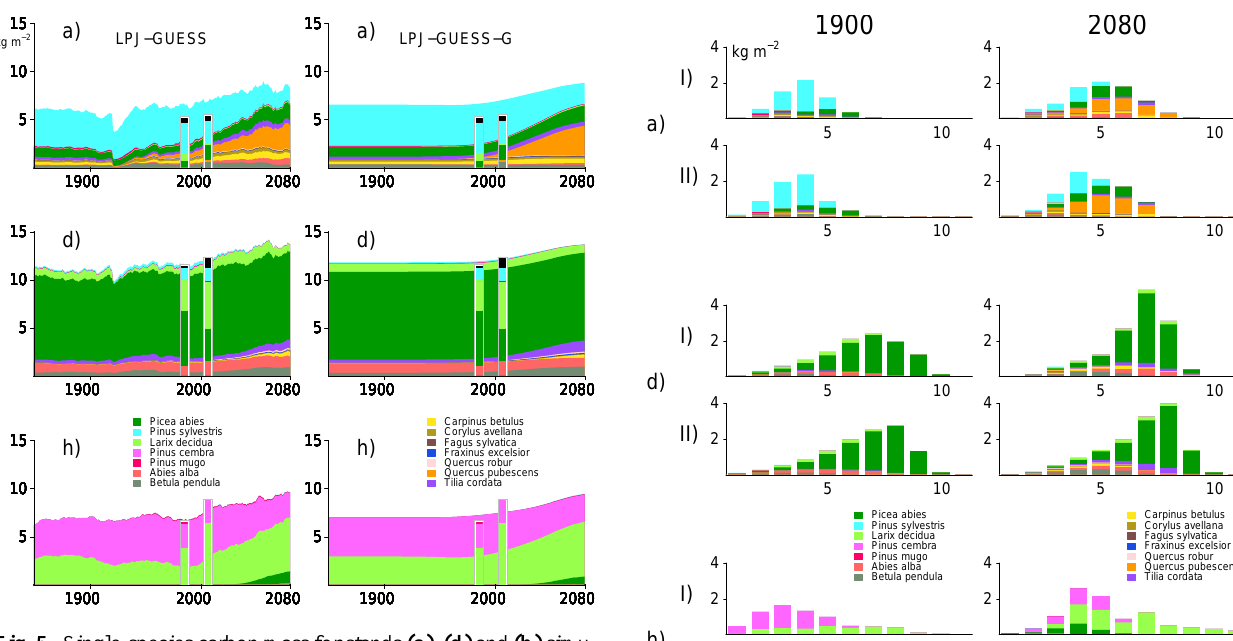
Fig. 5. Single-species carbon mass for stands (a) , (d) and (h) simu- lated with LPJ-GUESS and LPJ-GUESS-G. LPJ-GUESS: stochas- tic simulation run using 400 replicate patches, LPJ-GUESS-G: GAPPARD applied to LPJ-GUESS. Development of carbon mass until 2080. Bars indicate the NFI1 (1985) and NFI3 (2006) data. Black bar sections stand for broad-leaved species that were not modeled. Fig. 6. Simulation results for stands (a) , (d) and (h) for the simula-